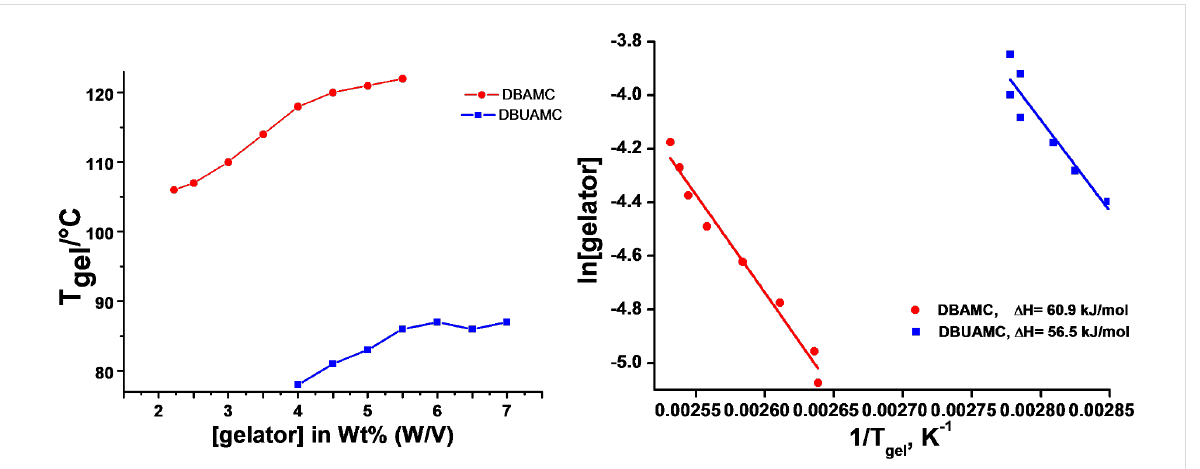
Figure 4: SEM micrographs of the xerogels. (a) & (b) 0.5 wt % 1,2- dichlorobenzene gel of DBAMC 6 ; (c) 0.8 wt % chlorobenzene gel